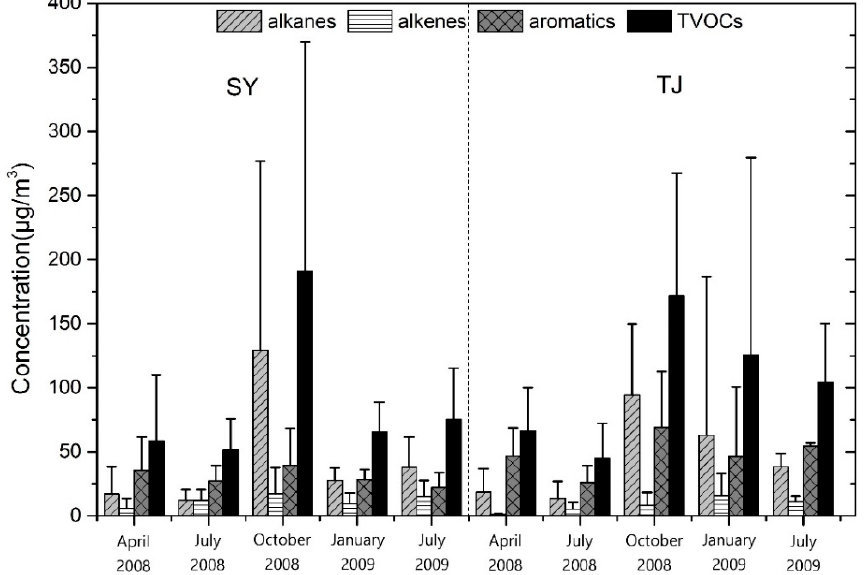
Figure 3. Concentrations of each chemical group (alkane, alkene, aromatics and TVOCs measured at Shenyang and Tianjin from 2008 to 2009. SY: Shenyang, TJ: Tianjin.